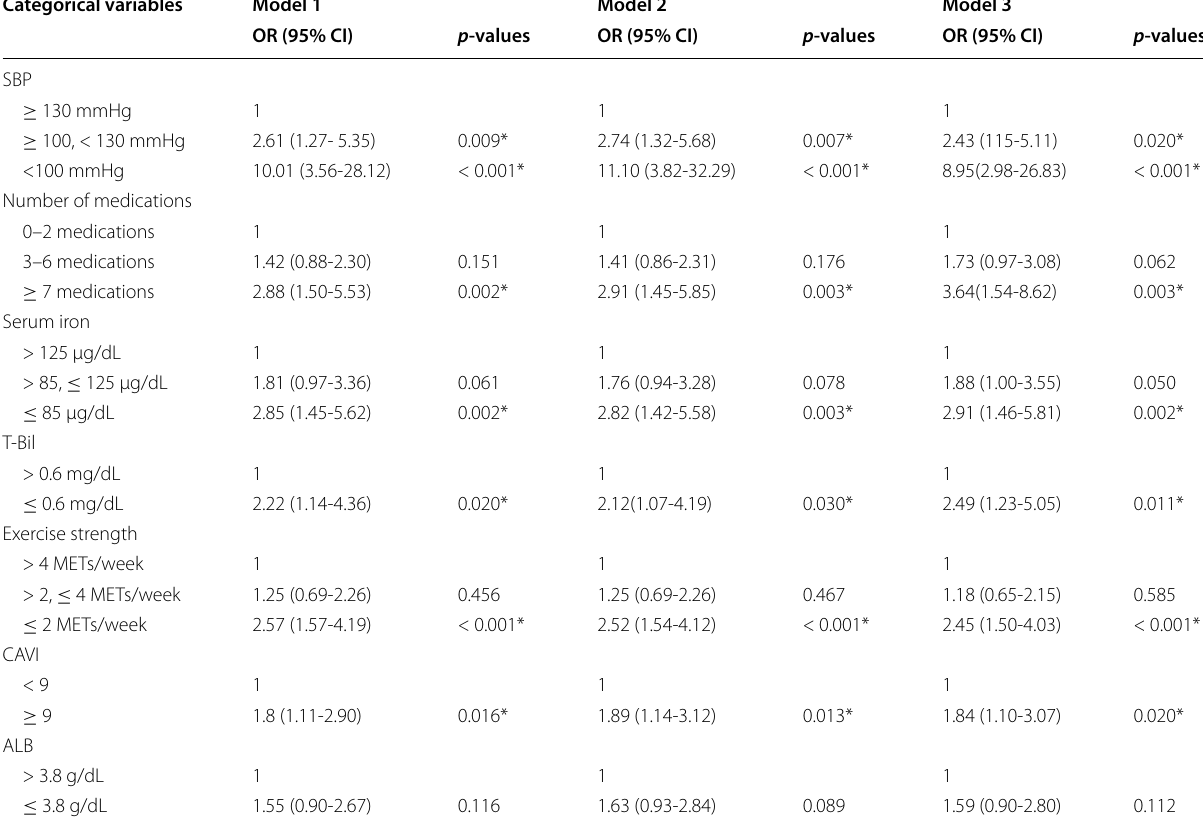
Table 3 Multivariate ordinal logistic regression analysis of risk factors for